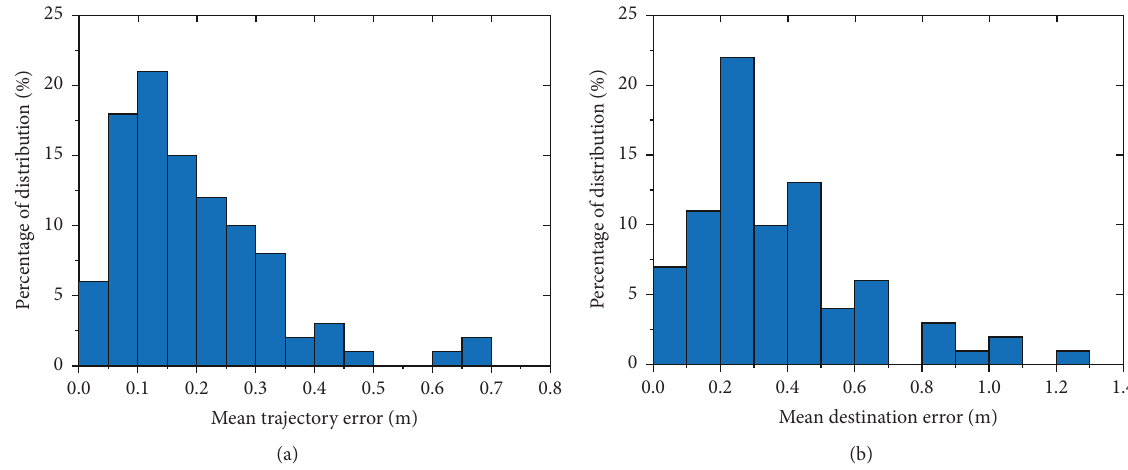
Figure 15: MTE frequency and MDE frequency of the bidirectional flow scenario. (a) MTE frequency. (b) MDE frequency.